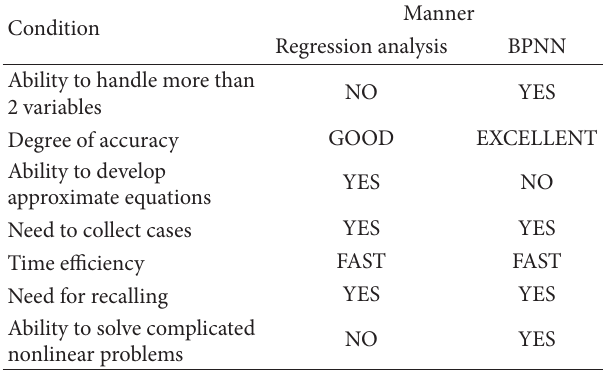
Table 7: Performance comparison: regression analysis versus